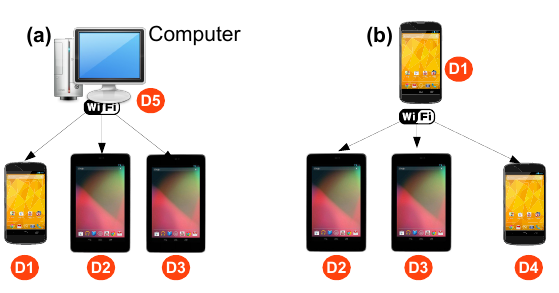
Figure 7. Experimental Testbed has been configured in two different ways: (a) Setup 1: Three mobile devices are connected to a laptop and (b) Setup 2: three mobile devices are connected to another mobile